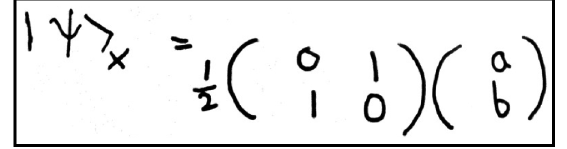
FIG. 5. A student ’ s written response when asked to write the general form of a state in the basis of S x . Here the student equates a state j ψ i x to the S x matrix acting on a generic column